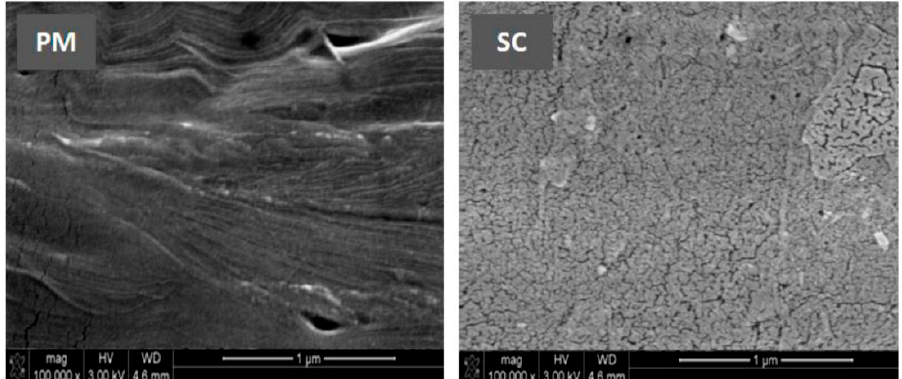
Figure 7. SEM micrographs of surface morphology of P δ -VL/TiO 2 -1 hybrid material